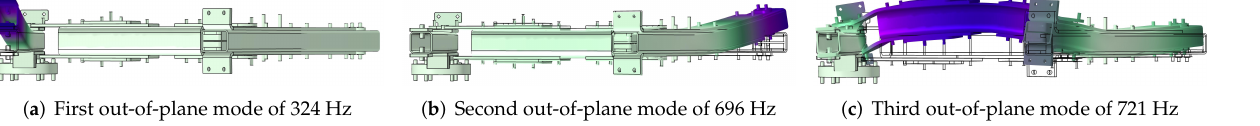
Figure 6. The first three out-of-plane mode shapes from finite element analysis at θ 1 = 88.2 deg. With dark blue the largest displacements due to the excitation of a specific mode shape are shown. The displacements are strongly